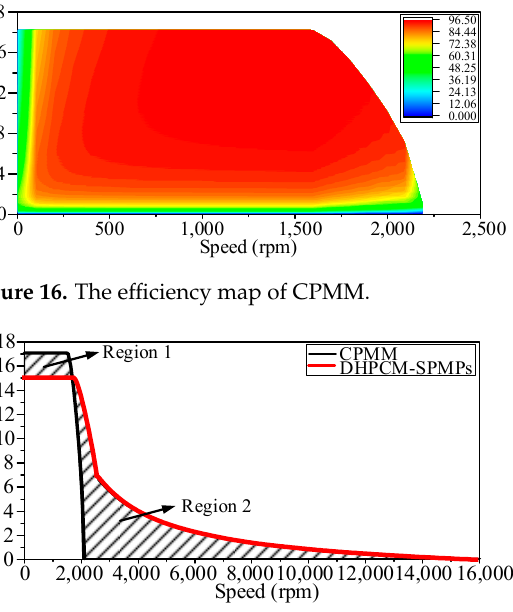
Figure 17. Torque–speed curves of the two motors.